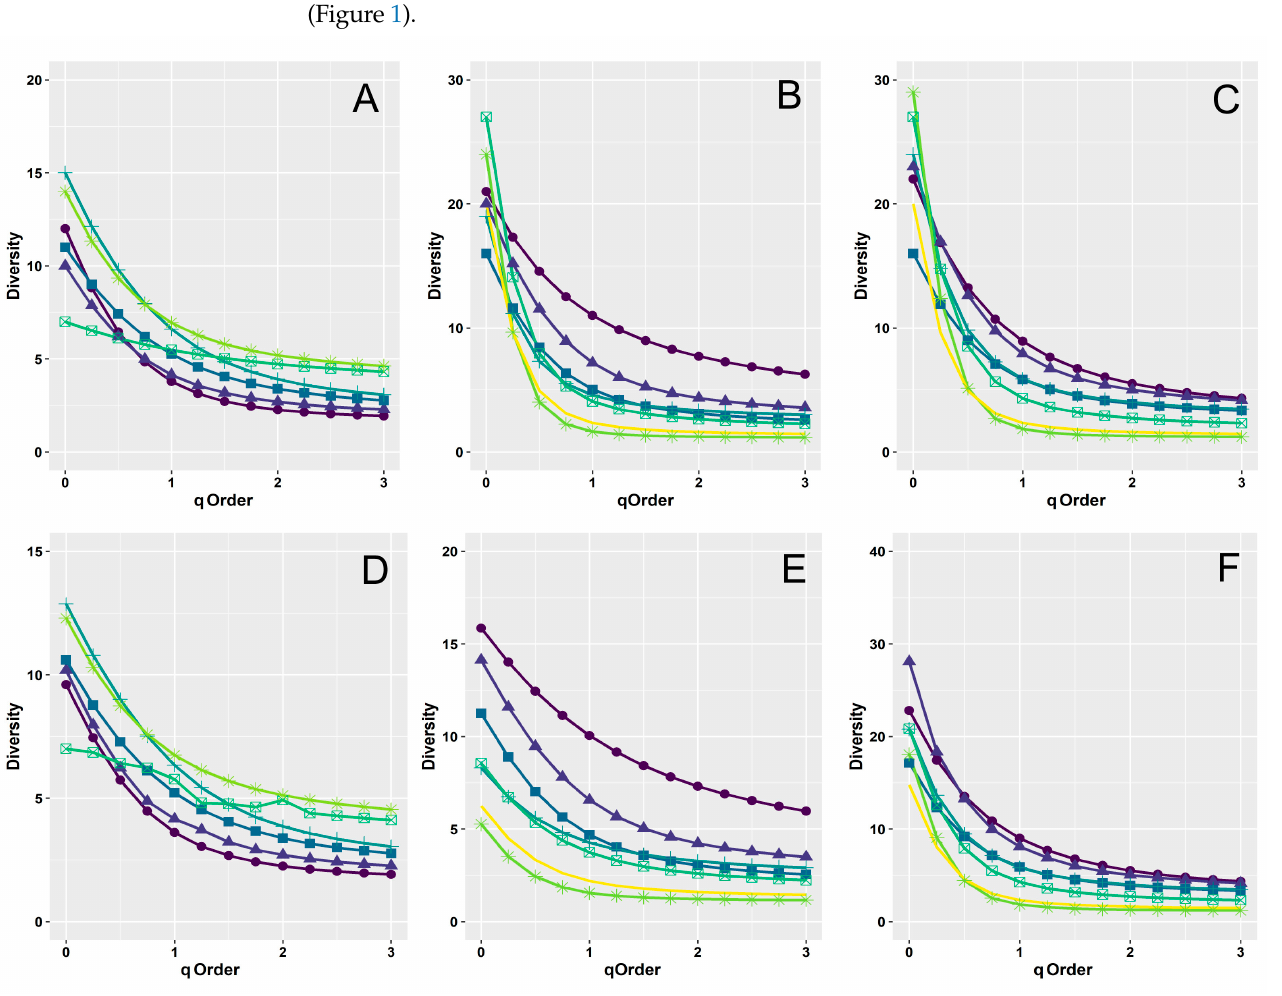
Figure 1. Diversity curves using Hill numbers for dung beetle assemblages along an elevational gradient in central Italy. Curves were constructed using empirical ( A – C ), rarefied/extrapolated ( D – F ), and asymptotic ( G – I ) values for the two habitats (woodlands and grasslands) separately (woodlands: A , D , G ; grasslands: B , E , H ) and merged ( C , F , I ). Dung beetles were sampled in seven altitudinal intervals (belts) of 150 m extent: Belt 1: 950–1100 m, Belt 2: 1100–1250 m, Belt 3: 1250– 1400 m, Belt 4: 1400–1550, Belt 5: 1550–1700, Belt 6: 1700–1850, Belt 7: 1850–2000. For ease of reading, 95% confidence intervals are not shown here, but they are reported in Figure S1. Using empirical values, woodland diversity curves clearly indicated a direct relation- ship between diversity and elevation (Figure 1A) for q ≥ 1.5; however, the confidence in- tervals were largely overlapping (Figure S1A). By contrast, grassland diversity curves (Figure 1B) showed distinct patterns of decreasing diversity with increasing elevation. For q = 0, diversity values were characterized by large uncertainties (Figure S1B) and did not show any clear relationship with elevation. However, with increasing q -values, confi- dence intervals became narrower, and diversity values showed distinct elevational pat- terns. The first belt (950–1100 m) showed the highest diversity followed by the second belt (1100–1250 m). Belts 3–5 (1250–1400, 1400–1550, 1550–1700 m, respectively) showed inter- mediate values with largely overlapping confidence intervals. The seventh belt (1850– 2000 m) showed a lower diversity, and the sixth belt (1700–1850 m) was that with the